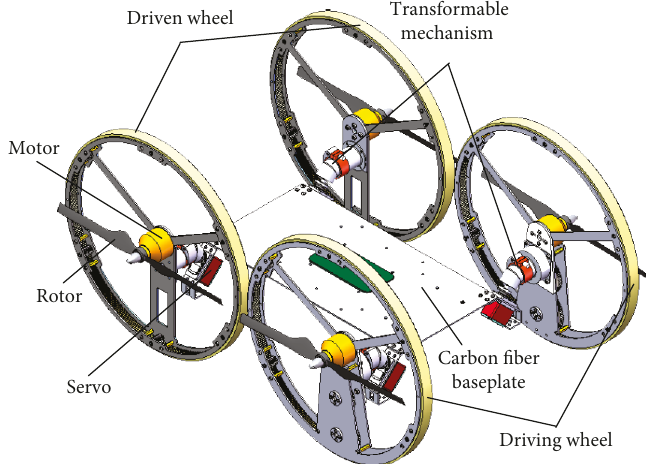
Figure 2: Con fi guration of the platform.